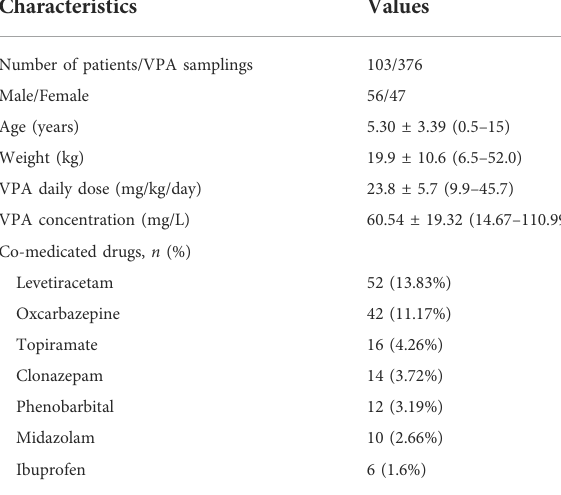
TABLE 1 A summary of demographic information in children with epilepsy.